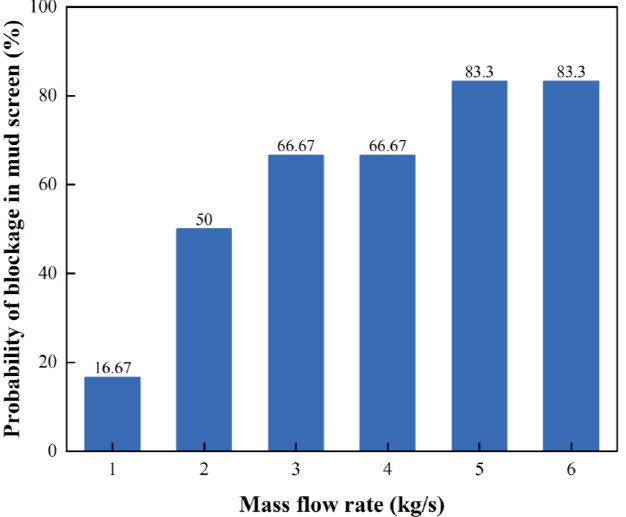
Figure 14. Influence of mass flow of LCMs on the probability of blocking in mud screen.